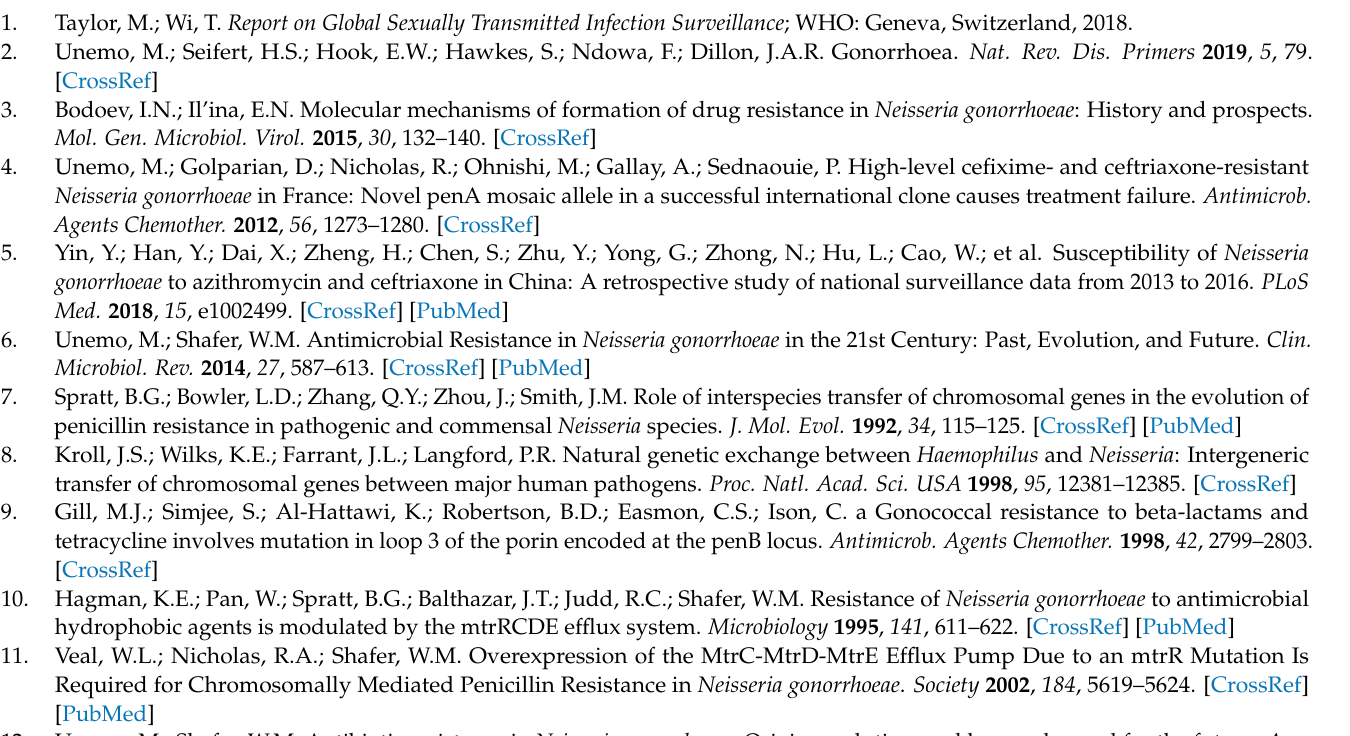
Table S2: Differentially expressed proteins found in both fractions, Table S3: Functional enrichment analysis of differentially expressed proteins, Table S4: Primers selected for analysis of N. gonorrhoeae genes, Figure S1. Functional classification of DAPs according to